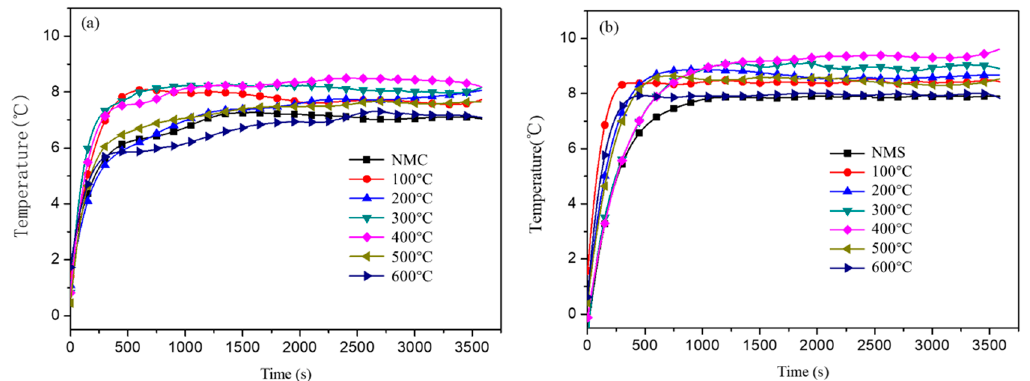
Figure 7. The temperature difference between inside and outside of plates coated with calcined shell powder as fillers ( a ) cement board, ( b ) steel plate. NMC (Nominal Mix Concrete) and NMS (Nano- Materials) represent cement board and steel plate coated with the coating filled by the as-received shell powder.